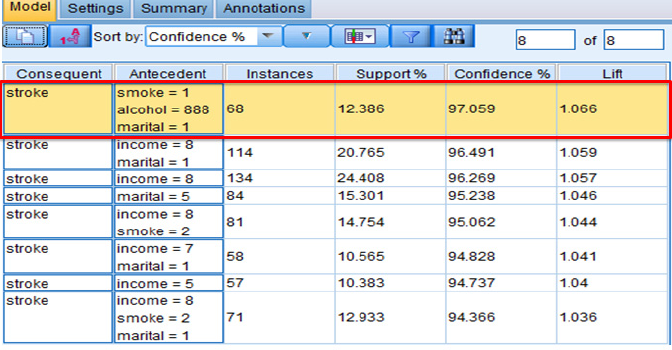
Figure 2. Association-interpreting the results.